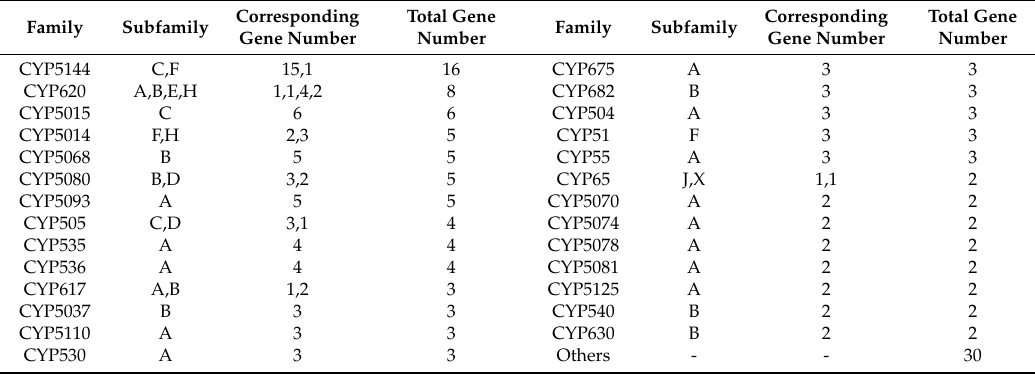
Figure 5. Genetic structures of sesterterpenoid synthase genes and their neighboring genes. Each gene is represented by an arrow. The aristolochene synthase gene (GI_10003231) is indicated by green color; the trichodiene synthase genes (GI_10004653, GI_10004654 and GI_10004694) are indicated by light blue color; the cytochrome P450 (CYP) genes are indicated by red color; choline dehydrogenase genes are indicated by yellow color; The Sec1-like protein genes are indicated by purple color. Table 2. Summary of the CYP genes in the G. incarnatum